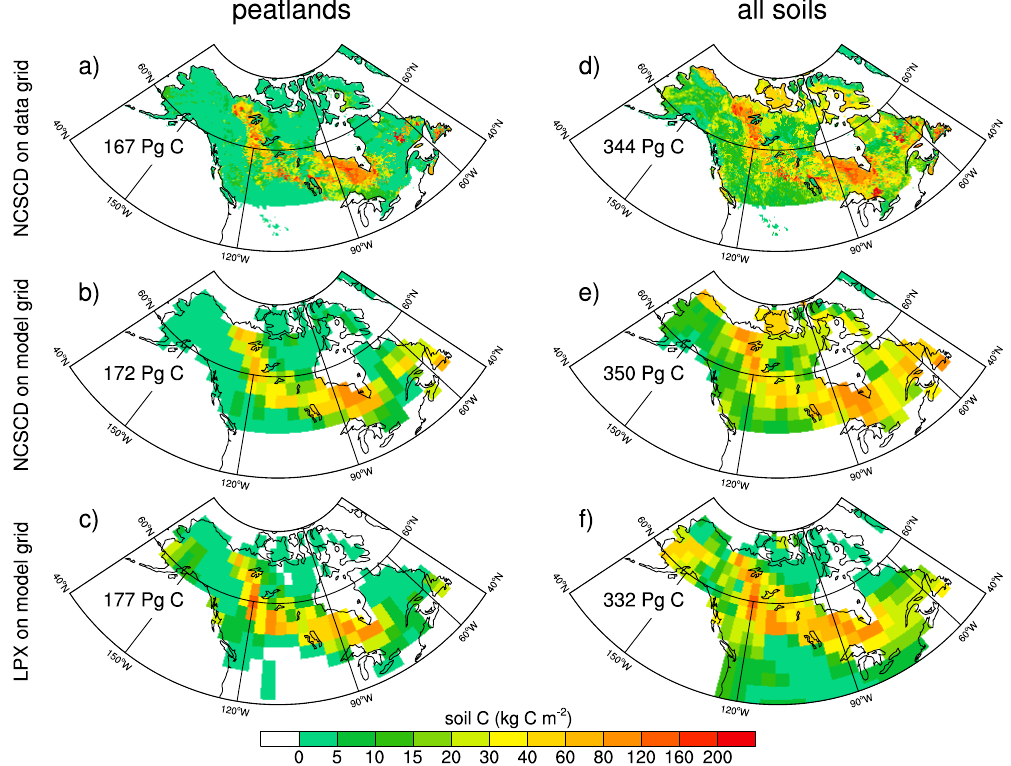
Fig. 8. Present-day distribution of peatland and all land (peatlands, permafrost and mineral soils) soil C densities in North America: (a) peat- land C density from NCSCD data (Tarnocai et al., 2007), (b) peatland C density from NCSCD data averaged on LPX grids, (c) peatland C density simulated by LPX, (d) all soils C density from NCSCD data, (e) all soils C density from NCSCD data averaged on LPX grids, (f) all soils C density simulated by LPX. Numbers denote the area-weighted total C